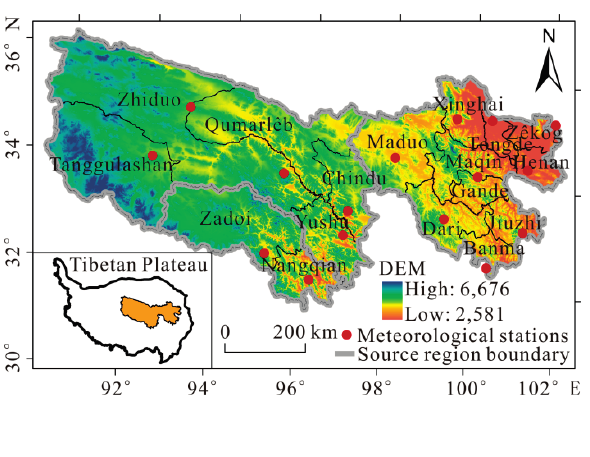
Figure 1. Study area and the distribution of meteorological